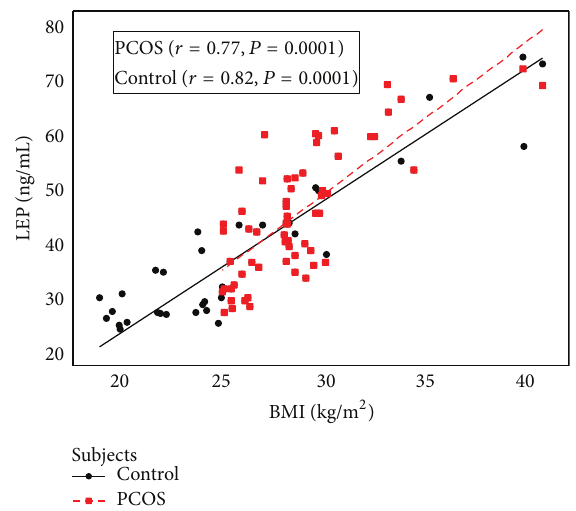
Figure 1: Correlation between serum leptin concentration and BMI in PCOS and control women.